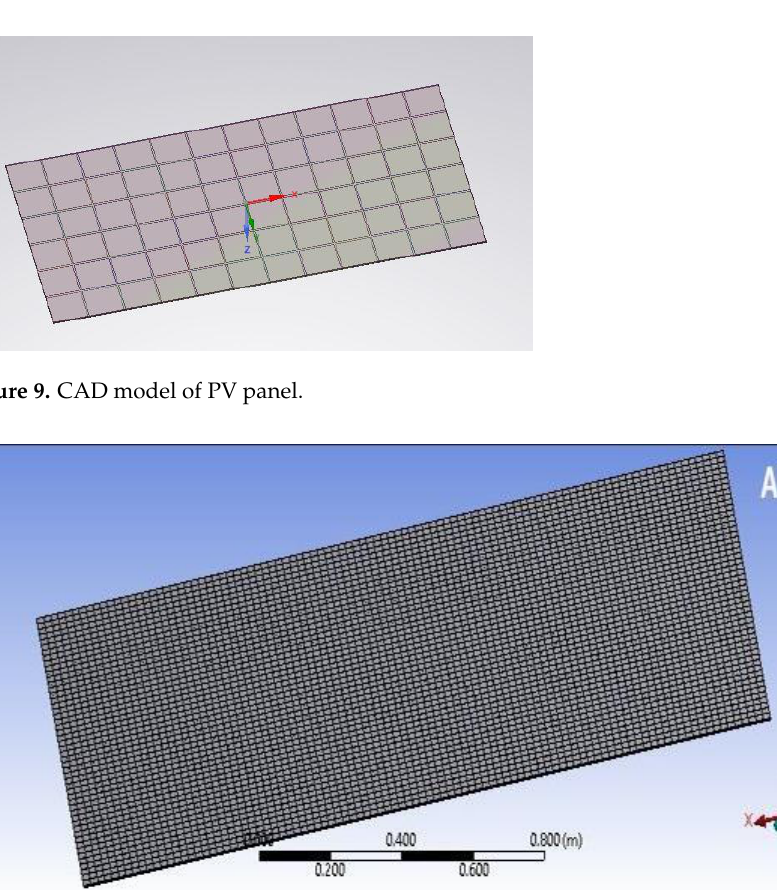
Figure 10. The hexahedral meshing of the PV module. The simulations show consistent temperature behavior of the PV module without cooling; see Figure 11. The maximum temperature of the solar panel was 83.415 °C.